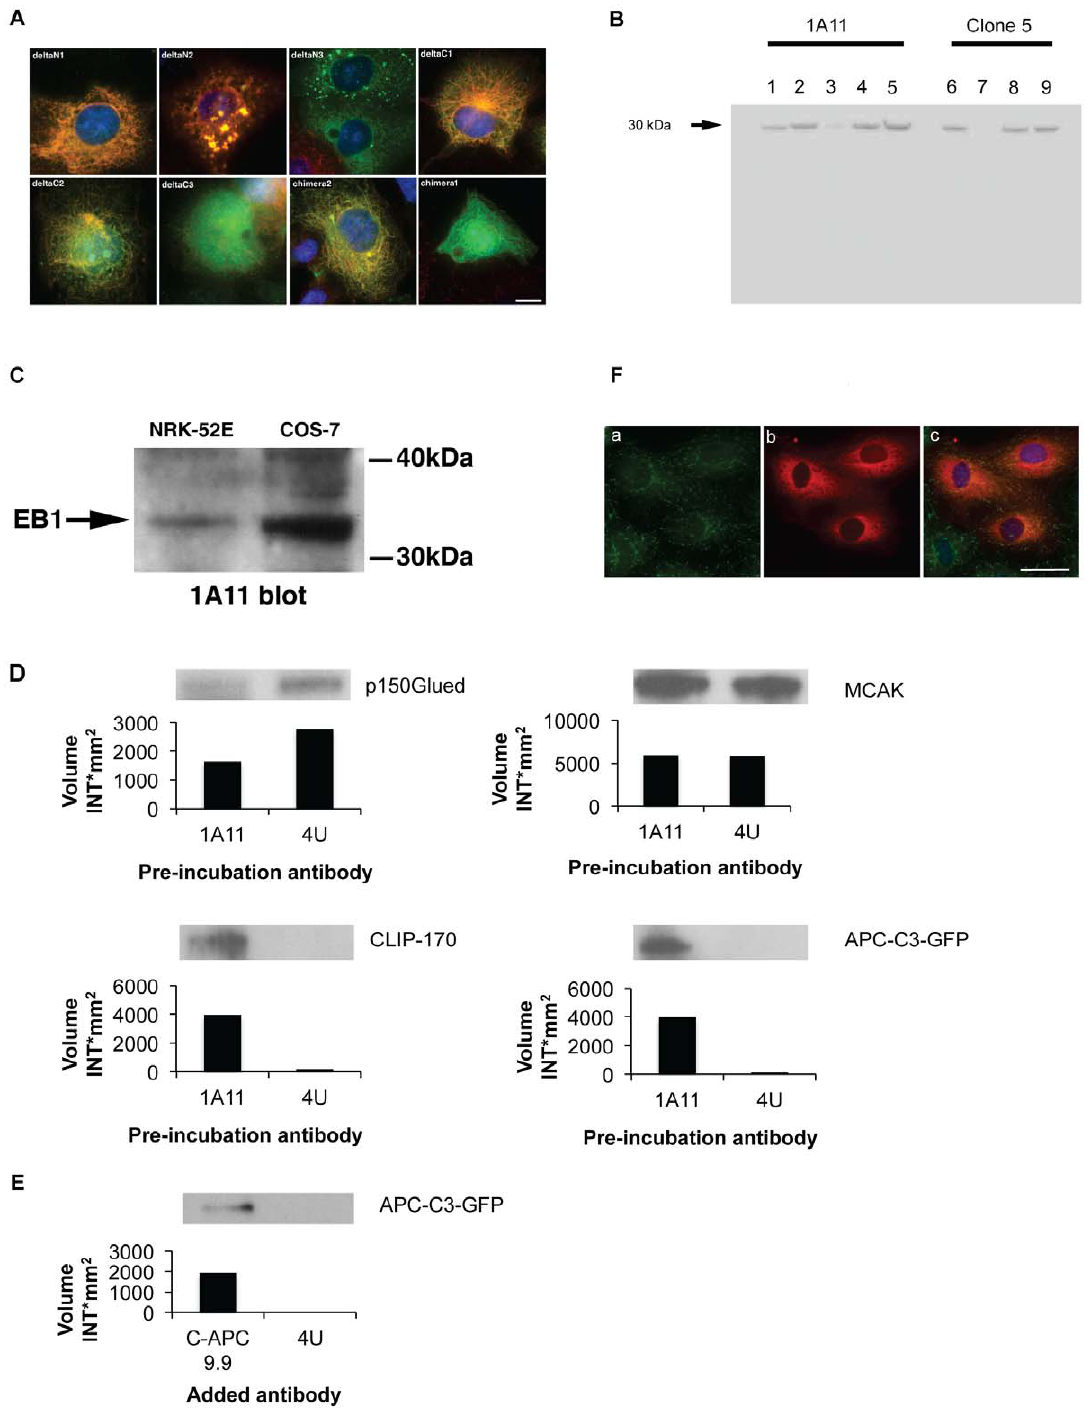
Figure 1. Functional characterisation of antibodies used in this study. Panel A. The epitope recognised by the EB1-specific monoclonal antibody 1A11 was mapped by co-immunostaining of COS-7 cells transiently transfected with a GFP-tagged EB1 deletion series (Table 1, [17]) and EB1/EB2-GFP chimeric proteins using anti-GFP antibodies (green) and the 1A11 antibody (red). DNA was counterstained using DAPI (blue). The presence of the 1A11 epitope was confirmed by co-localisation of GFP and 1A11 staining. Chimera1 is an EB1/EB2 hybrid protein, while chimera 2 is an EB2/EB1 hybrid. This analysis indicated that the 1A11 epitope lies between aa131–168. Scale bar=10 m m. Panel B. Specificity of antibody 1A11 is revealed by RNAi experiments. Binding of EB1 is greatly reduced in lysates after EB1 knockdown (lane 3), but not after EB2 (lane 4) and EB3 (lane 5) knockdown. Binding to EB1 is also present in the negative control (scrambled RNA, lane 2) and in normal HeLa cell lysates (lane 1). Similar results are obtained with commercial EB1 antibody clone 5. EB1 knockdown (lane 7) reduced binding of this antibody, whereas knockdown of EB2 (lane 8) or EB3 (lane 7) or with scrambled oligos (lane 6) did not affect EB1 binding. Panel C. EB1 is recognized in lysates from COS7 and NRK-52E cells by 1A11 after Western blotting. Panel D. Effects of 1A11 binding on EB1 interactions with ligands. GST-EB1 bound to glutathione-agarose beads was pre- incubated with 1A11 or non-specific IgG (4 U) before being used in pull-downs from cell extracts. Bound proteins in each pull down were revealed by